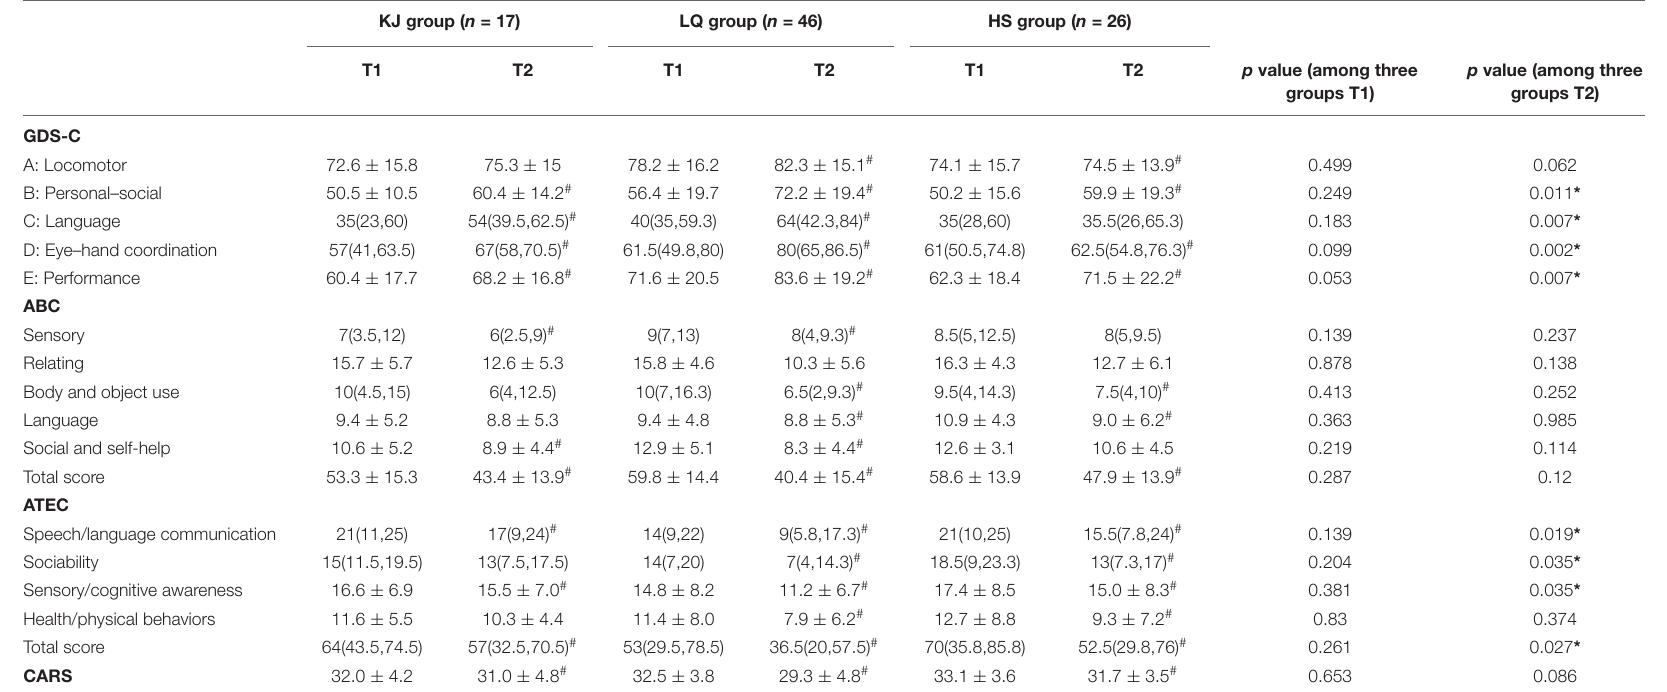
TABLE 3 | Comparison of the GDS-C, ABC, CARS, and ATEC scores between T2 and